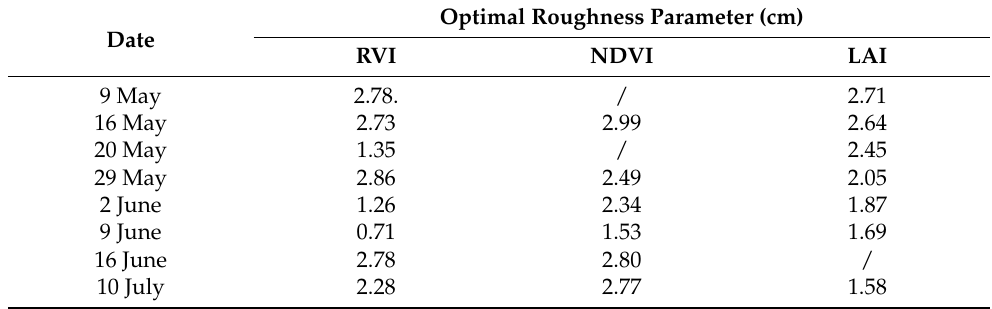
Table 3. The value of optimal roughness parameter when different vegetation parameters were used as vegetation description parameters (Ratio method).